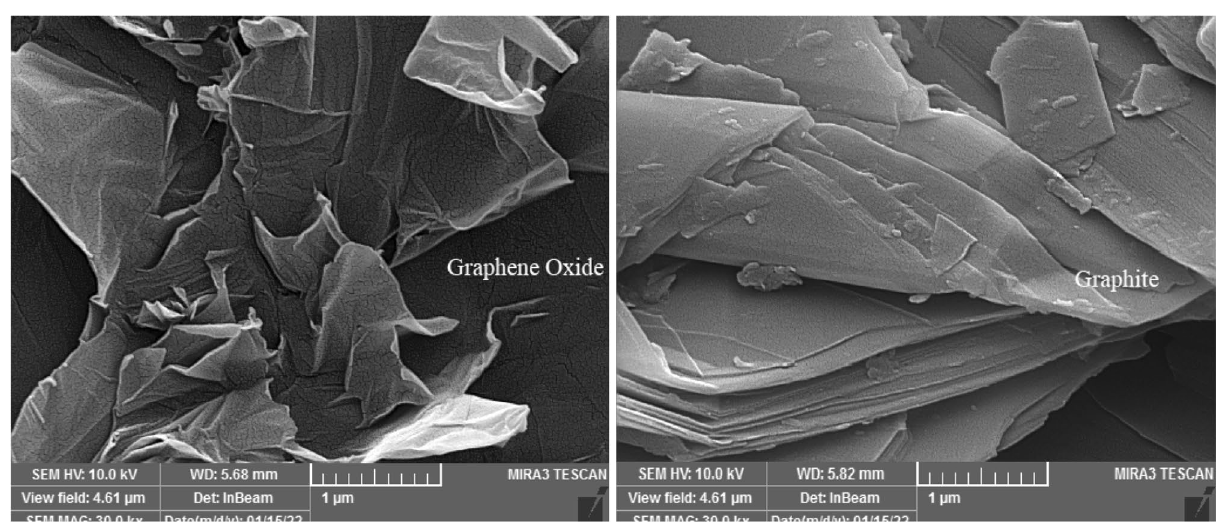
Figure 3. SEM of graphite and graphene oxide